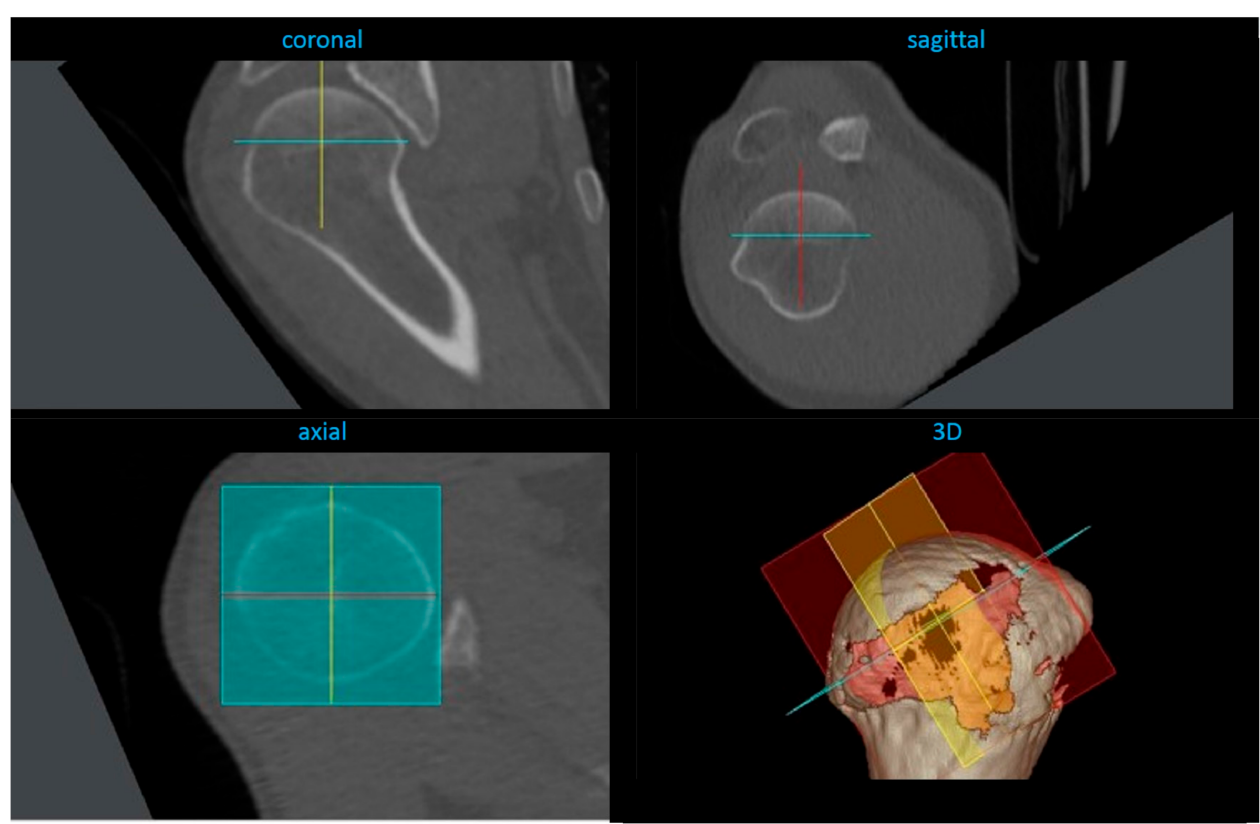
Figure 3. Three-dimensional humeral head coordinate system in sagittal, axial, and coronal planes and a 3D reconstruction. The distance from the humeral head center and condyle–humeral-axis center served as a scale for calculations of the geometrical parameters. These were calculated within the three-dimensional humeral head coordinate system in the sagittal, axial, and coronal planes, respectively (Figure